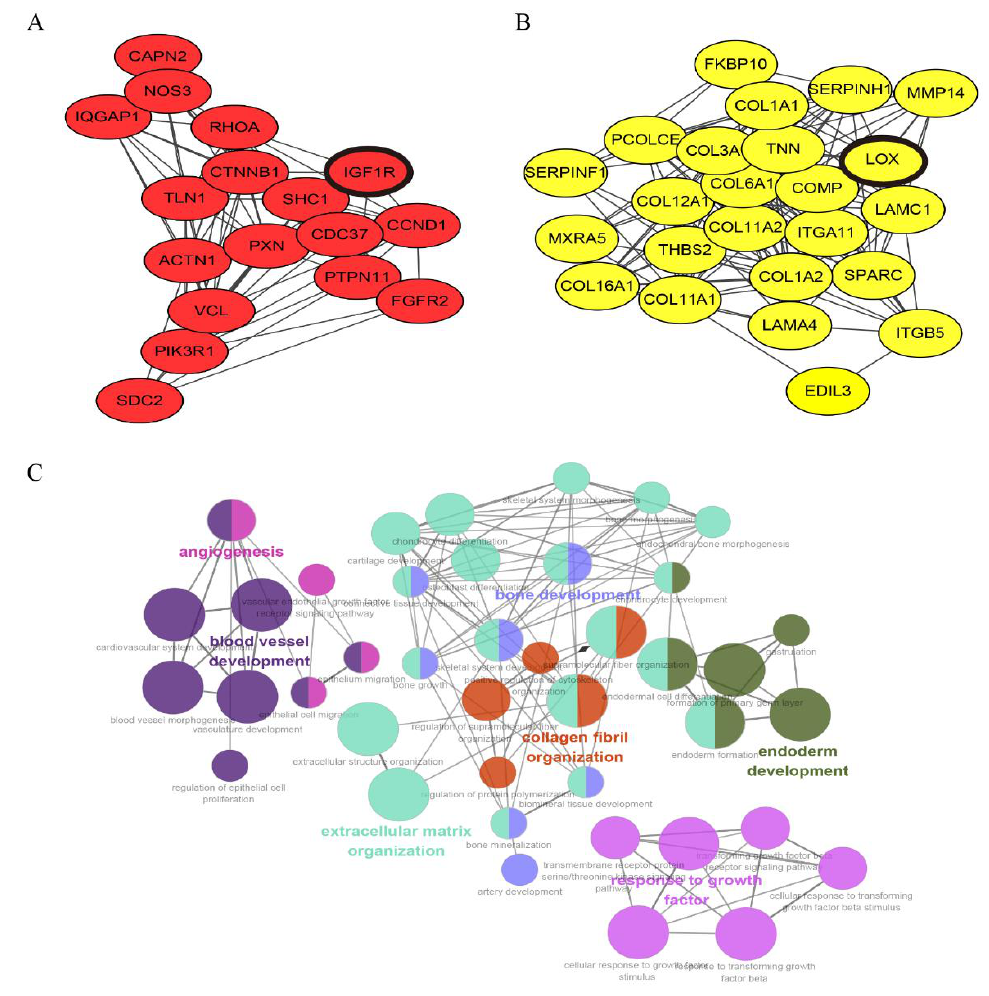
Figure 4. Gene interaction network related to antler growth rate. The interaction network of 277 antler-growth-rate-related genes identifies two sub modules with most of the 49 minor genes, namely the IGF1R module ( A ) and LOX module ( B ), and they were relatively close to each other in the whole interaction network. Enrichment networks of 277 genes were constructed using Cytoscape plug-in Cluego ( C ), and each node is a representative enrichment pathway. The connection of nodes represents the number of genes shared between the pathways, and the color indicates the classification of the node enrichment. The results show that these genes have significant interactions in biological processes such as bone development, extracellular matrix organization and collagen fibril organization. Table 1. The 49 genes in the biological functions and signaling pathways that are related to antler growth rate.